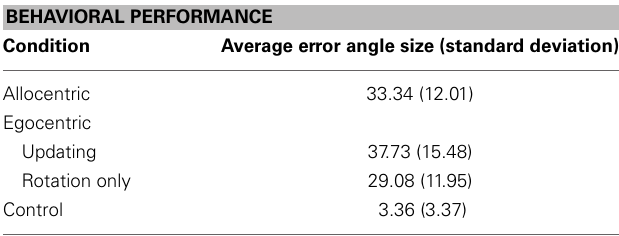
Table 1 | Average angle size error (with standard deviations in parentheses) in the object pointing task for each